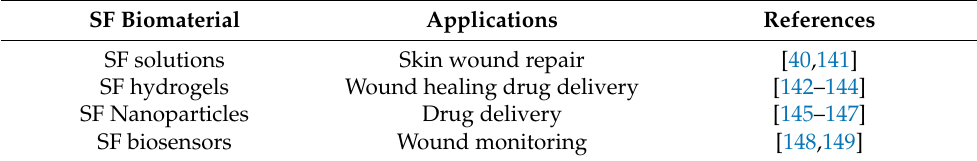
Table 5. SF-based drug delivery systems for wound